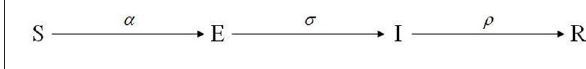
FIGURE 2 | Classic SEIR